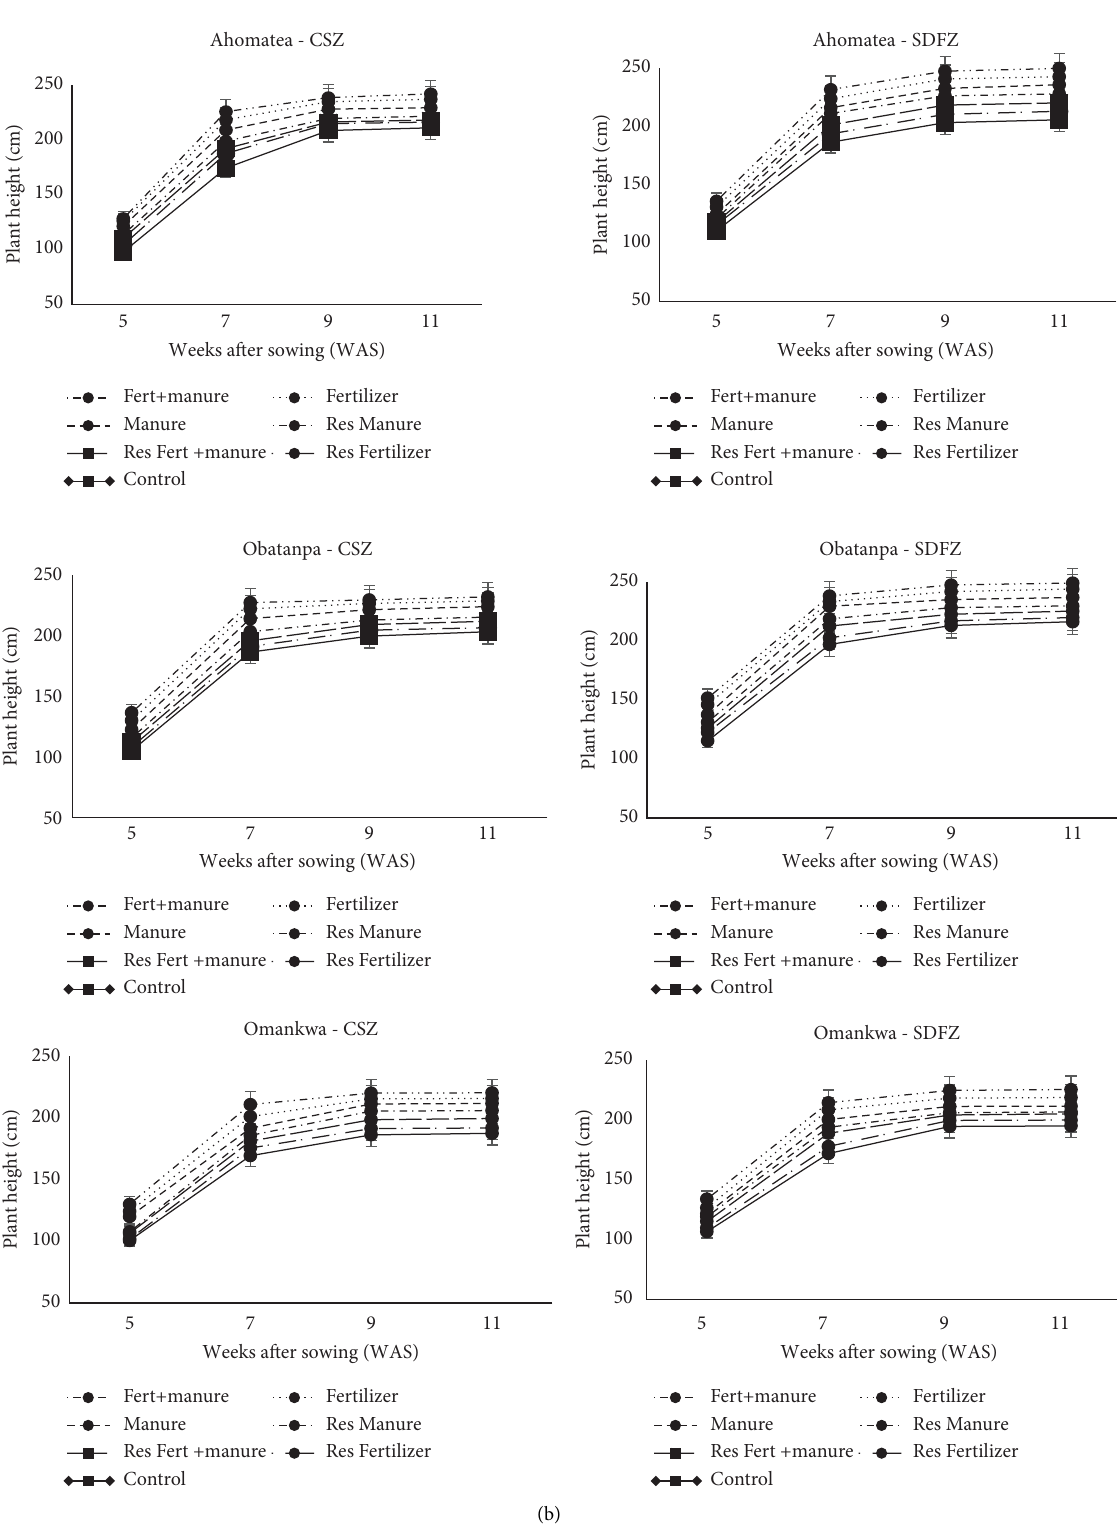
Figure 2: (a) Plant height (cm) of Ahomatea, Obatanpa, and Omankwa maize varieties at 5, 7, 9, and 11weeks after sowing (WAS) under diferent soil amendments in the coastal savannah (CSZ) and semi deciduous forest (SDFZ) zones of Ghana during the 2017 major cropping season. (b) Plant height (cm) of Ahomatea, Obatanpa, and Omankwa maize varieties at 5, 7, 9, and 11weeks after sowing (WAS) under diferent soil amendments in the coastal savannah (CSZ) and semi deciduous forest (SDFZ) zones of Ghana in the 2017 minor cropping